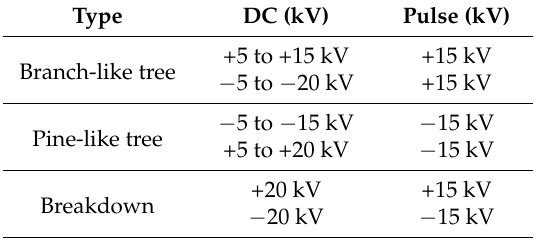
Figure 7. Typical trees at 60 min: ( a , b ) branch like tree; ( c , d ) pine-like tree. Table 1. Tree structure distribution under different combined voltages at 60 min.